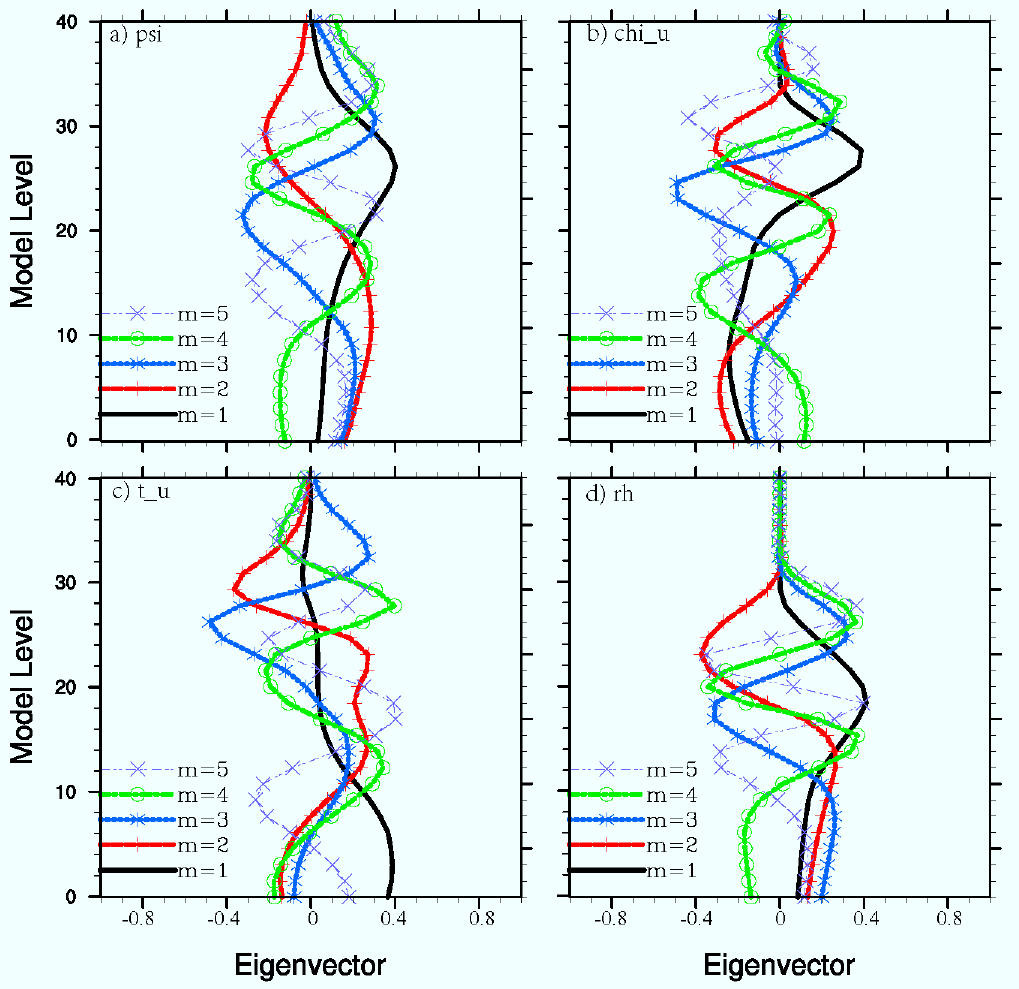
Figure 2. Five eigenvectors of control variables: a) stream function; b) unbalanced part of velocity potential; c) unbalanced part of temperature; d) relative